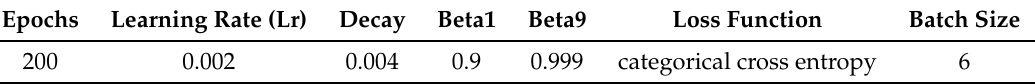
Table 1. Training parameters for multi-class classification with the Nadam optimizer.